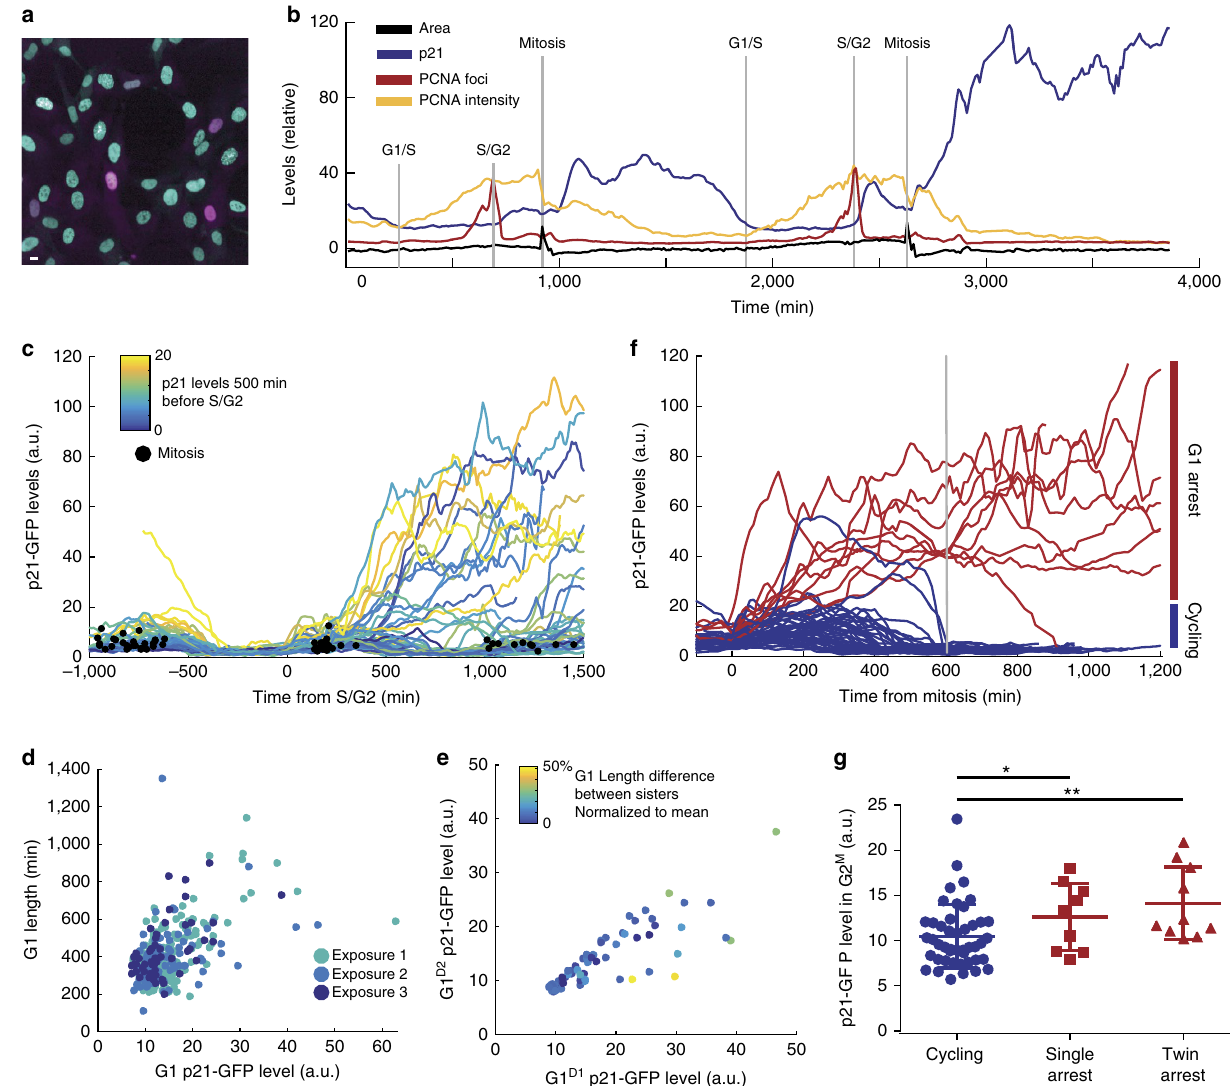
Figure 1 | Cells exhibit cell-to-cell variability in p21 expression. ( a ) Image of p21-GFP (magenta) and mRuby-PCNA (turquoise) expressing hTert-RPE1 cells. Scale bar is 10 m m. ( b ) Cell features captured by automated image analysis (Methods) from a single cell expressing mRuby-PCNA and p21-GFP. ( c ) Single-cell traces of p21-GFP levels aligned to S/G2; n ¼ 51 cells. Tracks are coloured according to p21-GFP intensity. Black circles represent mitosis. ( d ) Correlation between maximum G1 p21-GFP intensity and G1 length (Pearson’s Correlation R ¼ 0.62** ( P o 0.01)). Three different 488nm exposures are shown: Exp1, n ¼ 206 cells; Exp2, n ¼ 90; Exp3, n ¼ 52 (Methods). ( e ) Correlation in G1 p21-GFP levels between sister cells—G1 Daughter1 (G1 D1 ) and